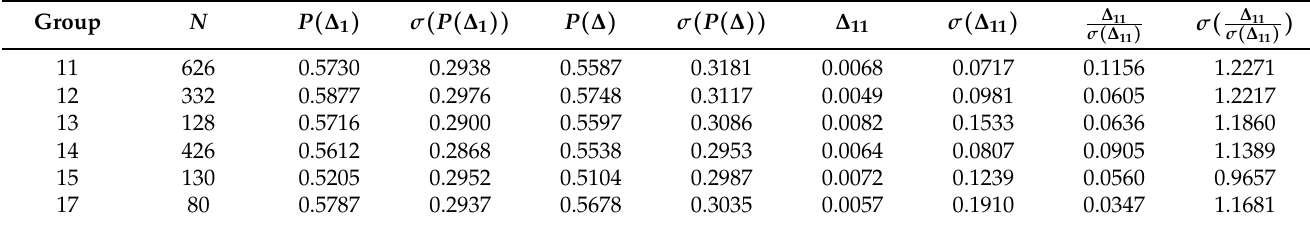
Table 8. Result of the numerical simulations—mean values of δ D angle statistical tests with standard deviations—part